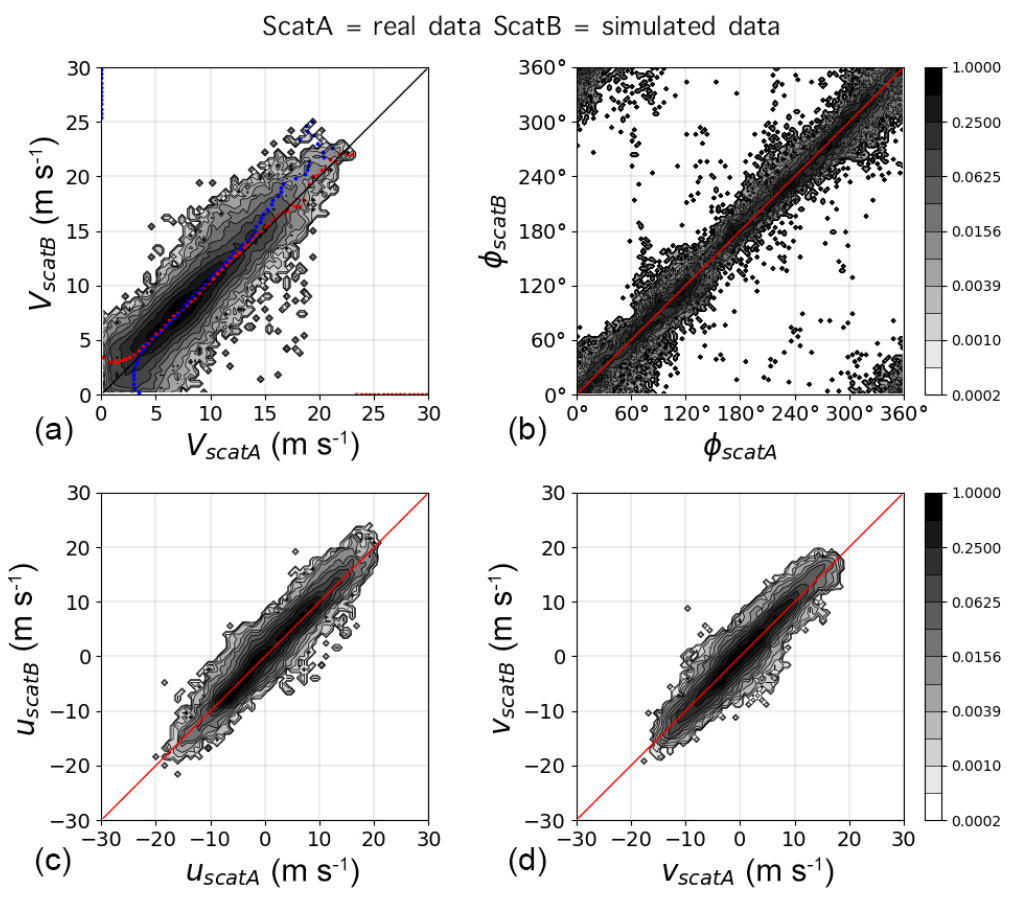
Figure 9. The collocation between SeaWinds (ScatA) and simulated SeaWinds (ScatB) in wind speed ( a : red points are the average value as a function of wind speed of ScatA; blue points are the average value as a function of wind speed of ScatB), wind direction (b) , u component (c) , v component (d) .